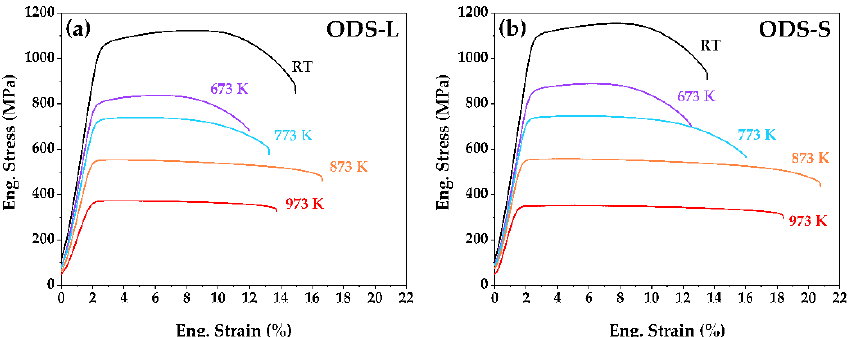
Figure 14. Representative stress-strain curves obtained from tensile test experiments performed on ODS steel samples annealed at 1273 K after HCR along the TS plane: ( a ) ODS-L; ( b ) ODS-S. Test temperatures ranged between RT and 973 K.